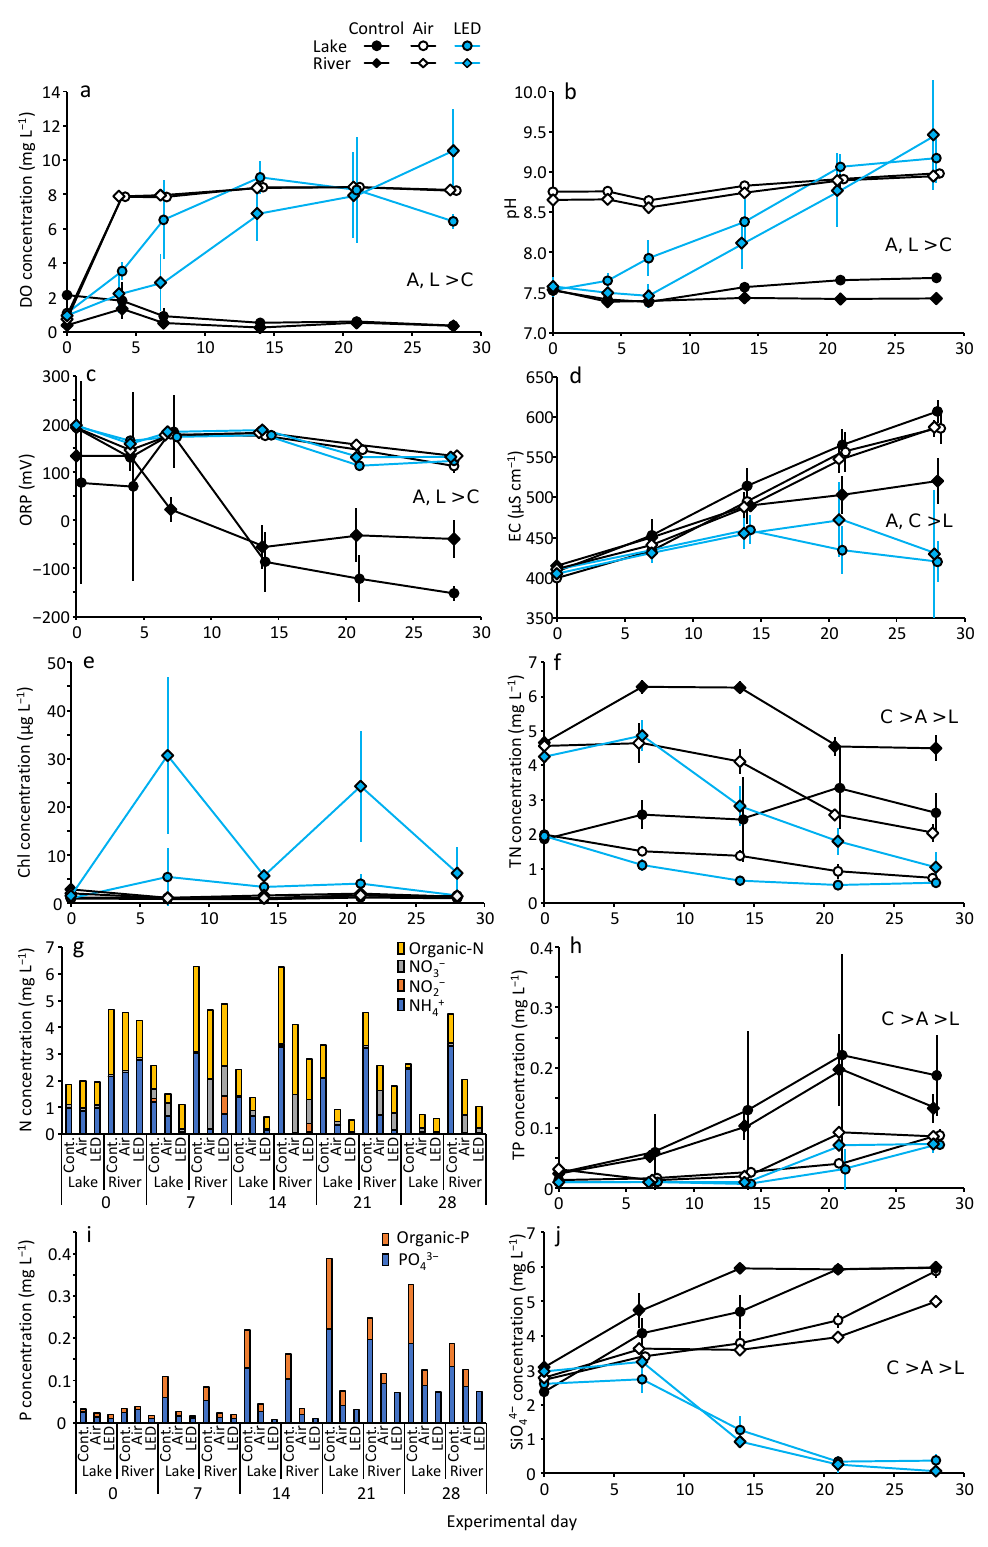
Figure 3. Changes in water quality (( a ) DO, ( b ) pH, ( c ) ORP, ( d ) EC, ( e ) Chl-a, ( f ) TN, ( g ) form of N, ( h ) TP, ( i ) form of P, ( j ) silicate) of microcosms with different treatments and sediment sources during the experiment. Significant difference among treatments at the end of the experiment is shown by > sign and the first character of treatment.